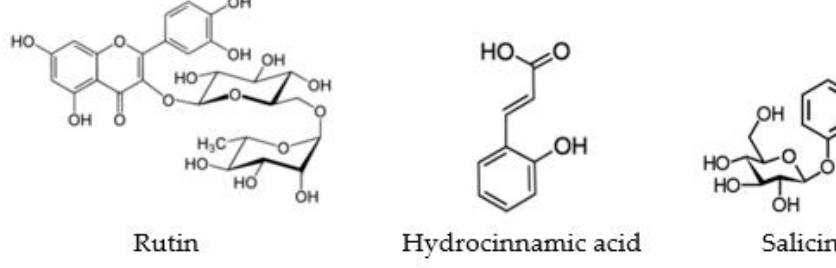
Figure 5. Most abundant phenolic compounds in stingless bee pollen.